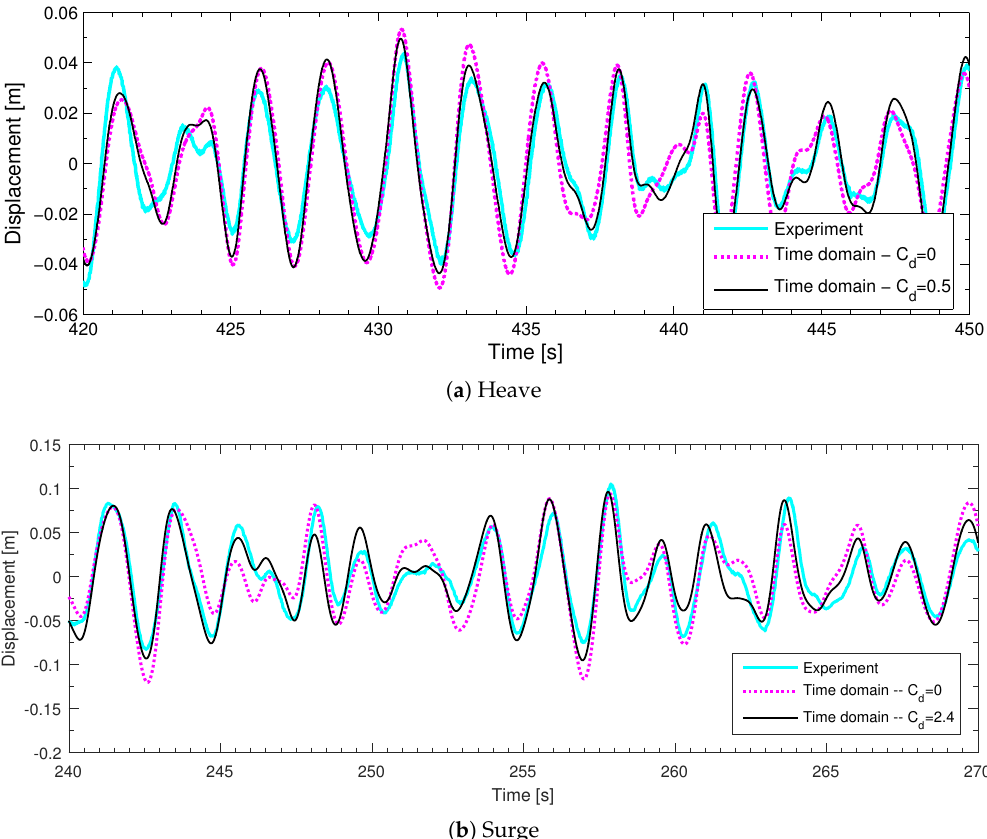
Figure 12. Experiment and time domain results with and without C d